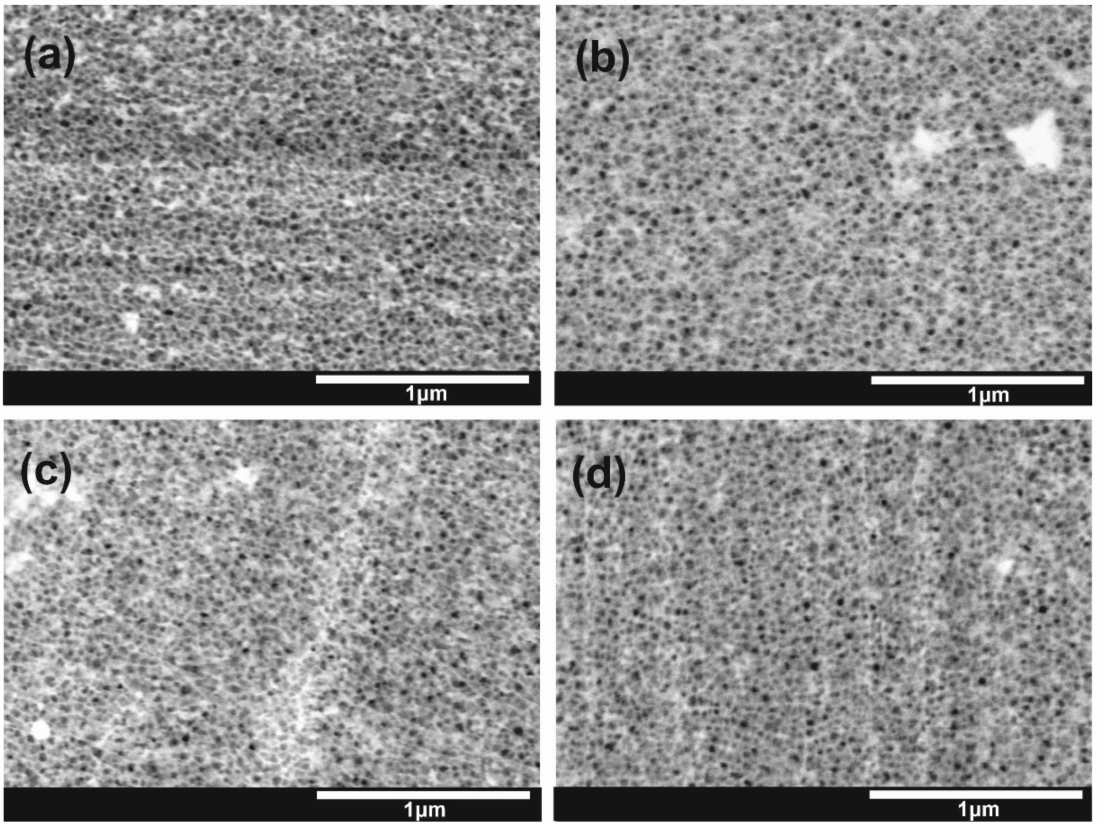
Figure 1. FE-SEM images of different types of SnO x layers after deposition of CdS: -/- ( a ), -/a ( b ), a/- ( c ), and a/a ( d